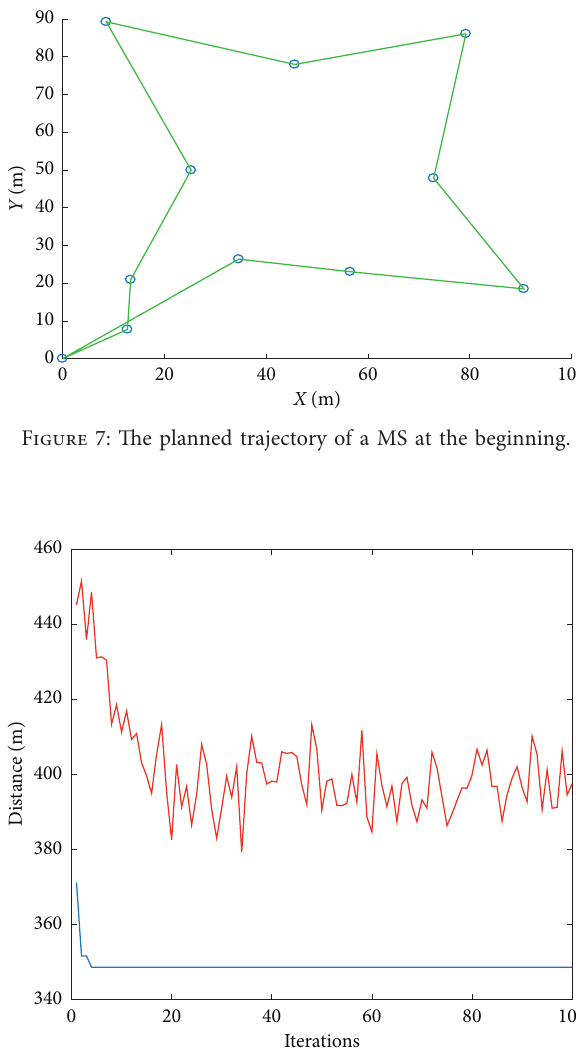
Figure 12. Again, the MS arrives at the head node of the first virtual cluster in the second subcycle. After node 3 being poll, the MS needs more energy to reach node 4. Therefore, it returns to the base station for preparing the third subcycle. ganized. The third subcycle is then defined as shown in Figure 13. The searching map for the optimal trajectory is shown in Figure 14. The shortest length over the field cannot be completed by the MS in one cycle. Therefore, the fourth subcycle is needed. The calculation for the third subcycle with the optimal is executed and the result is shown in Figure 15.